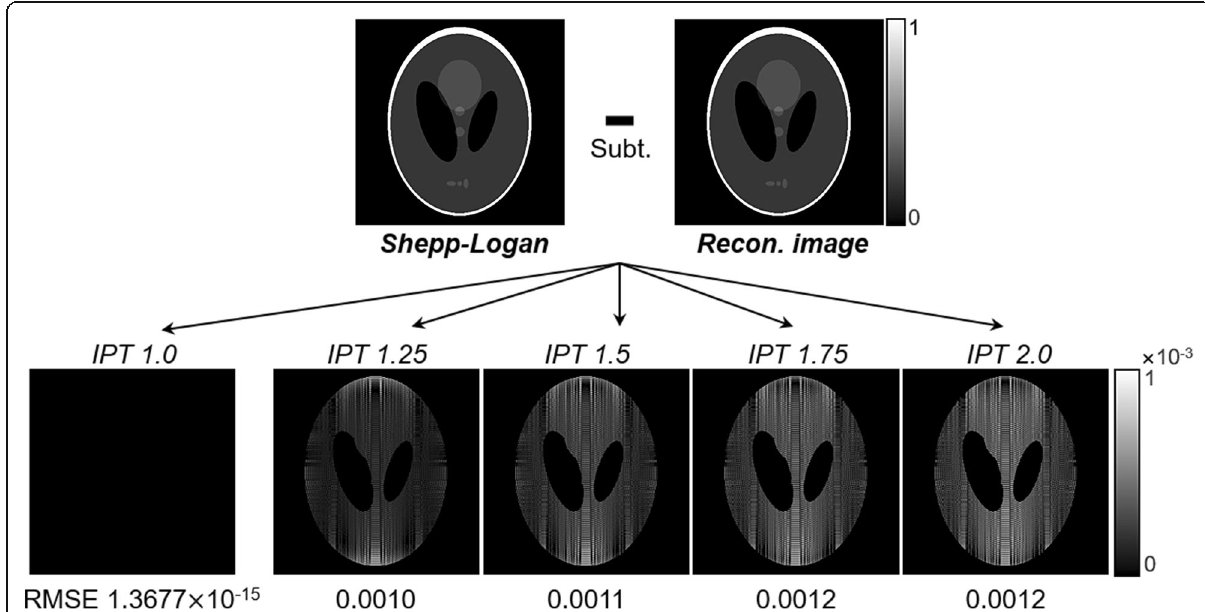
Fig. 1 Evaluation of zero-padding effect with respect to each implementation. The reconstructed images at 384 × 384 were subtracted from the Shepp – Logan image. According to the IPT factor, the signal intensity of the subtraction image is gradually increased. A substantial growth in RMSE is observed when the IPT is 1.25. Recon-image, reconstructed image; Subt, subtraction; IPT, interpolation factor; RMSE, root-mean-squared error